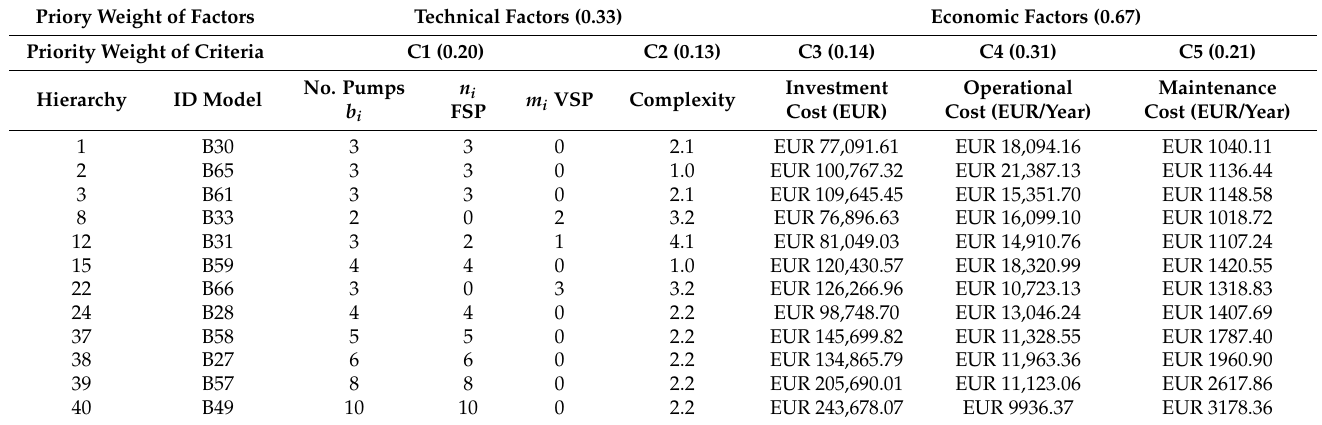
Table 8. Assessment of the criteria for each alternative (TF-PS1).